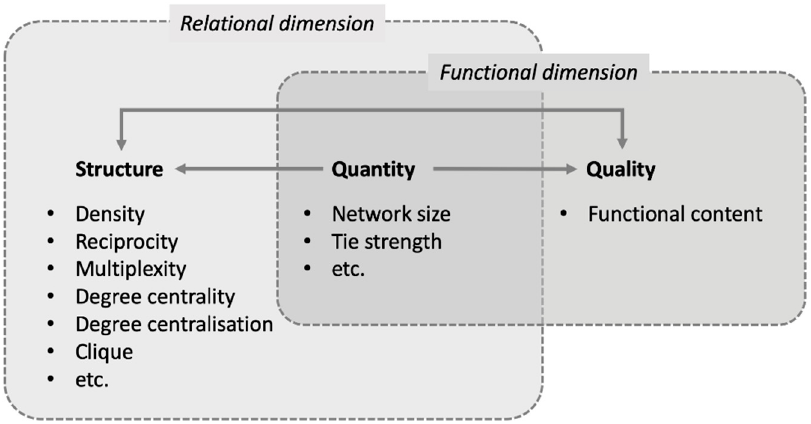
Figure 4. Theoretical model for analyzing peer-support networks.